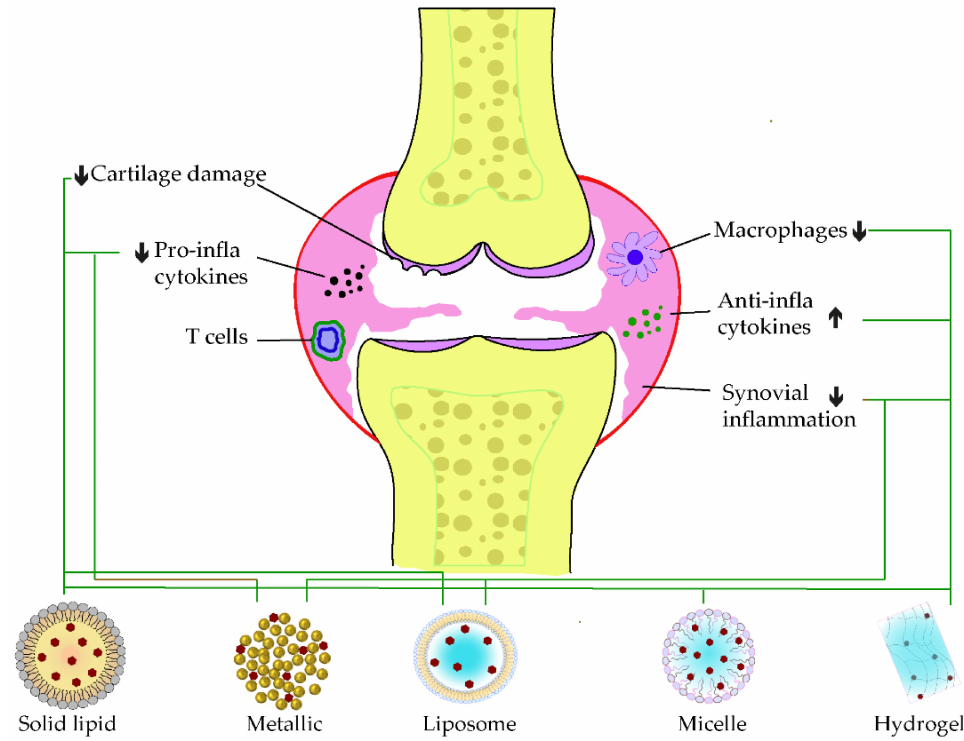
Figure 4. Examples of nanocarrier delivery of polyphenolics and their targets in Rheumatoid arthritis. The black arrows up signify the increasing while the down ones indicate the decreasing effects. The black dots in the figure consist of pro-inflammatory cytokines, the red dots are anti-inflammatory cytokines, and the yellow dots represent the bone marrow. The bold lines match the nanocarriers and their respective